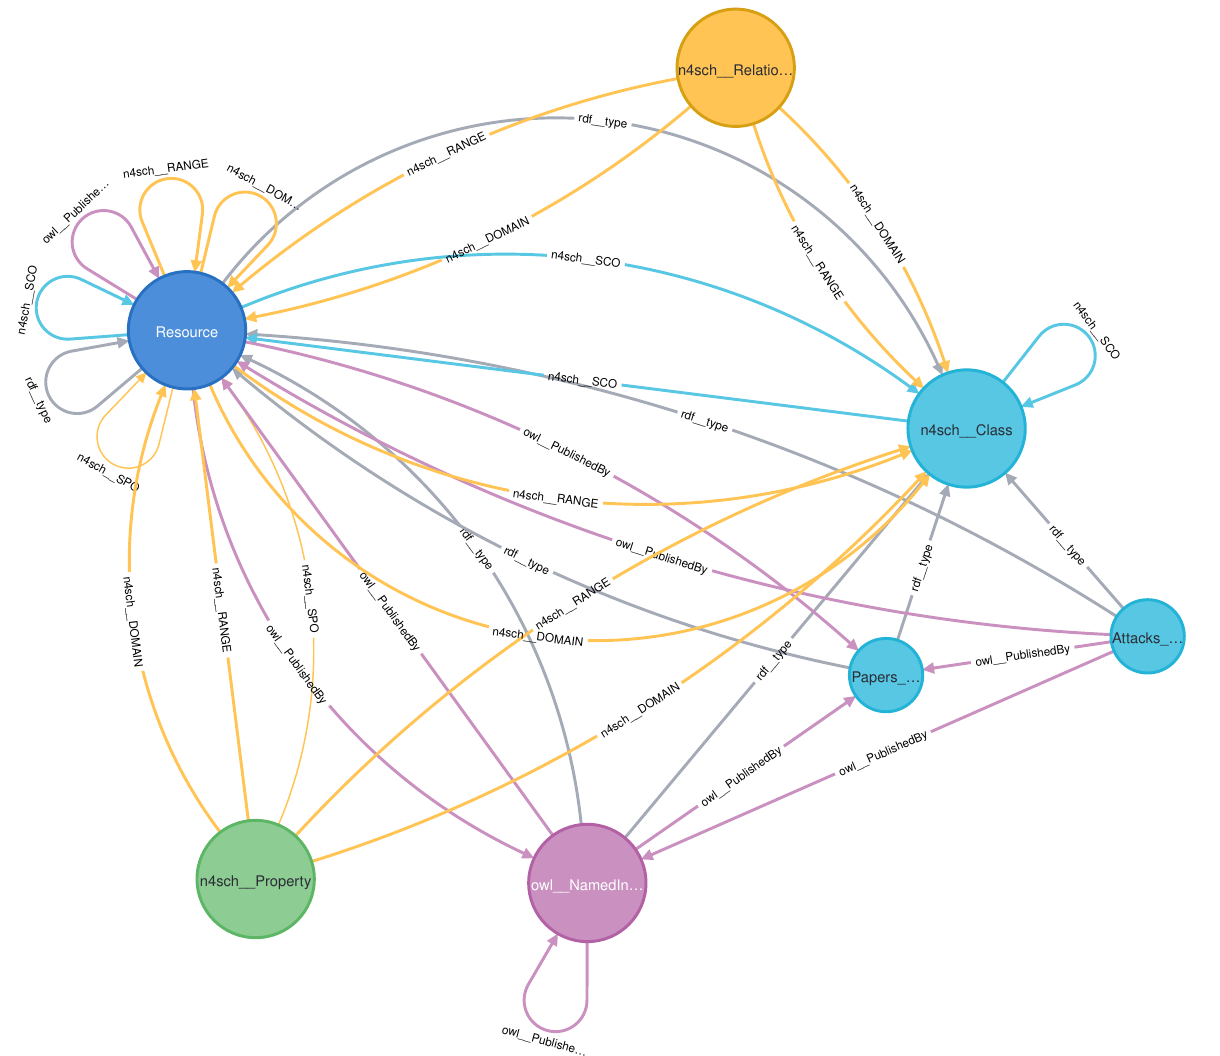
Figure 10. Meta-graph of the DNNPAO in Neo4j database.